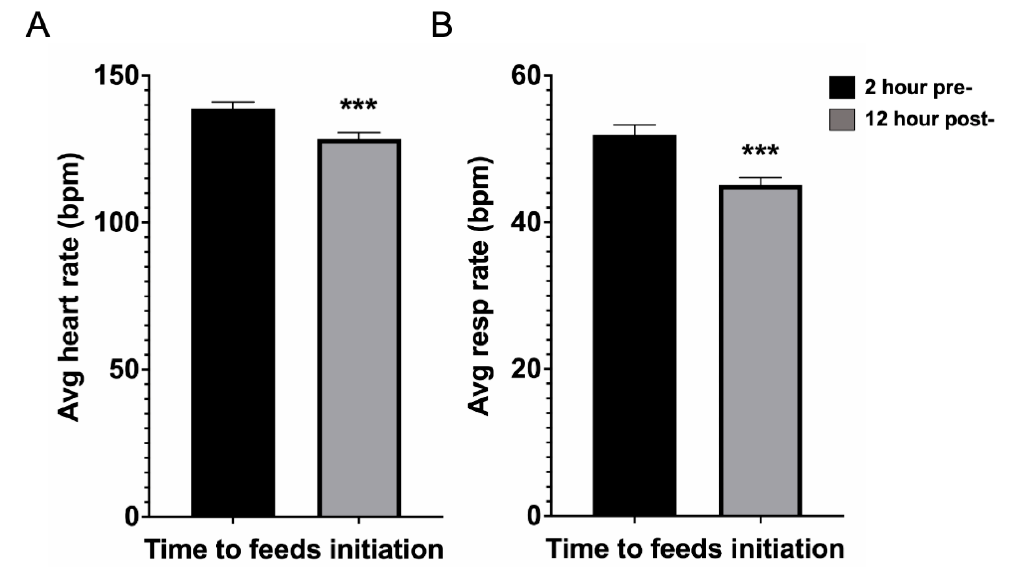
Figure 2. Physiometric parameters for the enteral nutrition (EN) group demonstrating ( A ) heart rate and ( B ) respiratory rate trends prior to (2 h pre-) and after (12 h post-) EN initiation. Data presented as mean ± standard error of mean. *** p < 0.001 by paired two-tailed Student’s t-test. Avg = average, bpm = beats/breaths per minute, resp = respiratory.